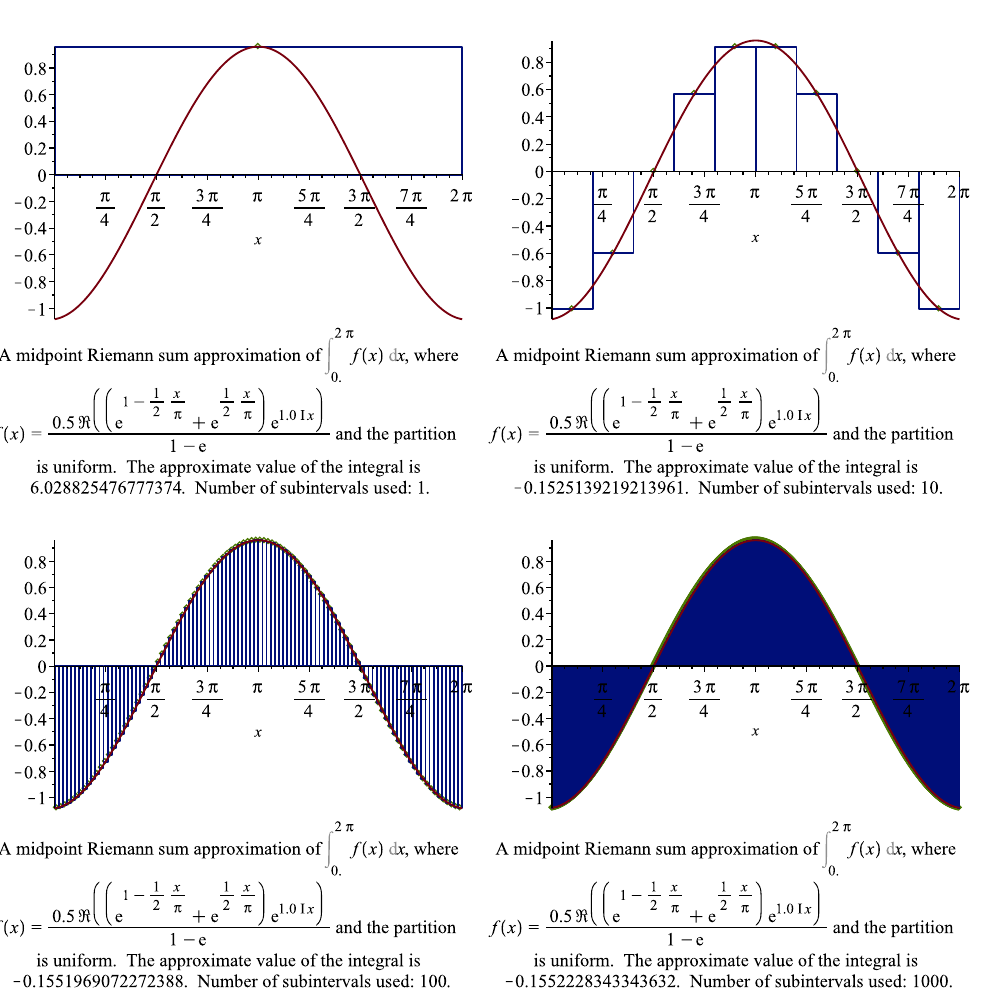
Figure 1. The process of convergence for the Midpoint rule when ω = 1 and N = 1, 10, 100, 1000 for the real part of the function f ( x )